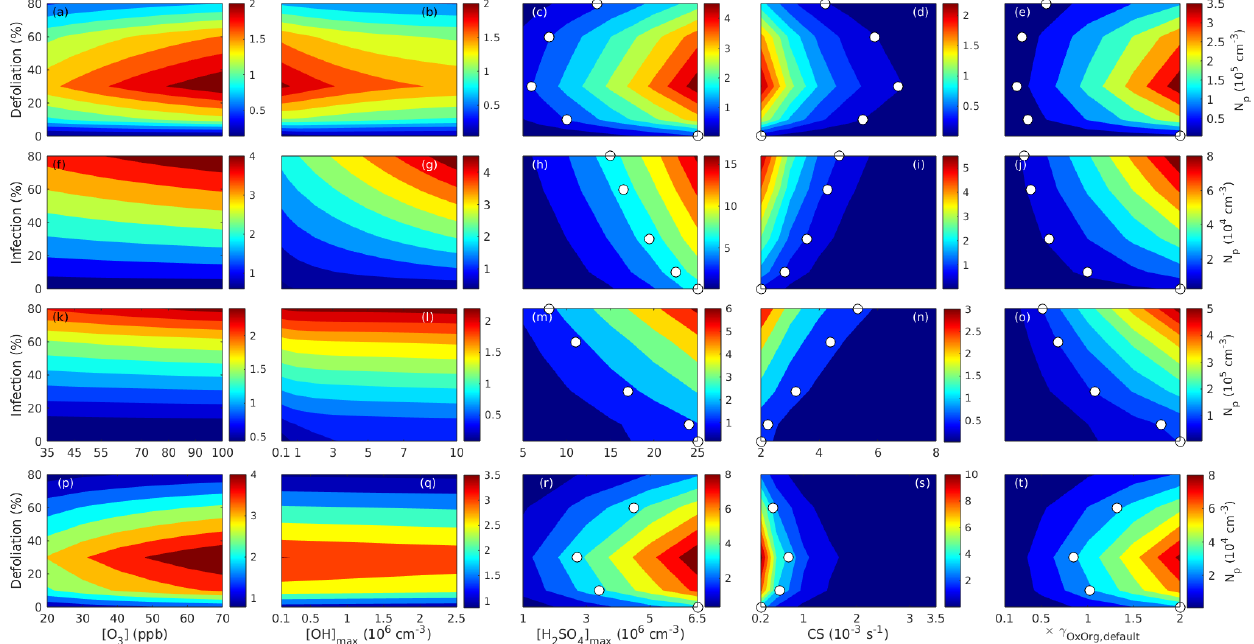
Figure 11. Impact of changed boundary conditions on the number concentrations of newly formed particles in non-infected and biotically stressed forest stands. The number concentration of newly formed particles is expressed as a function of changes in the concentration of ozone (a, f, k, p) , OH (b, g, l, q) , and sulfuric acid (c, h, m, r) , the condensation sink (d, i, n, s) and OxOrg yields (e, j, o, t) for non-infected and infected oak ( a–e , gypsy moth, f–j , powdery mildew), poplar (k–o) , and birch (p–t) stands. The concentrations of OH (b, g, l, q) and sulfuric acid (c, h, m, r) are given as the daily maxima, but in the simulations the parameters follow a daily cycle. White markers are used in a similar way as in Fig. 10. Be aware that the x axes are different for simulations in Hohenpeißenberg (a–o) and SMEAR I conditions (p–t) except in the case of changing OxOrg yields (e, j, o, t)